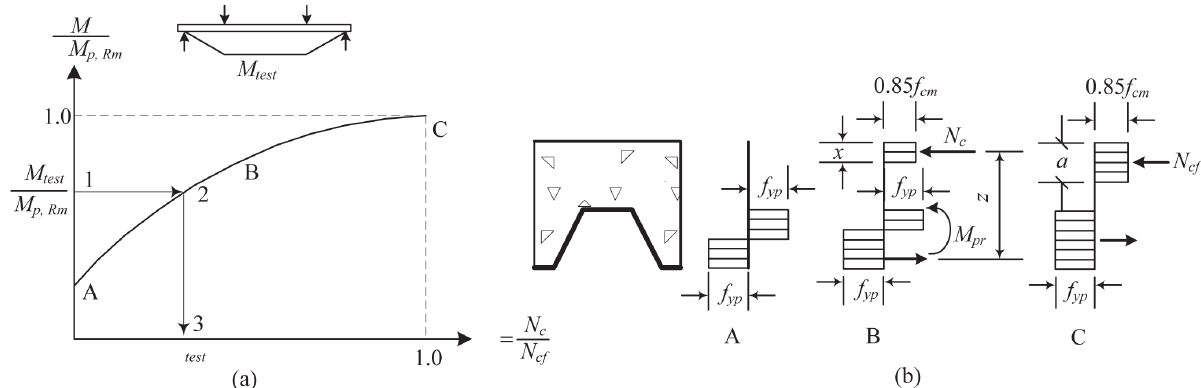
Fig. 2. Determination of the intensity of shear interaction using the PSC method: a) Partial interaction curve; b) Stress distributions at points A, B, and C (Eurocode 4